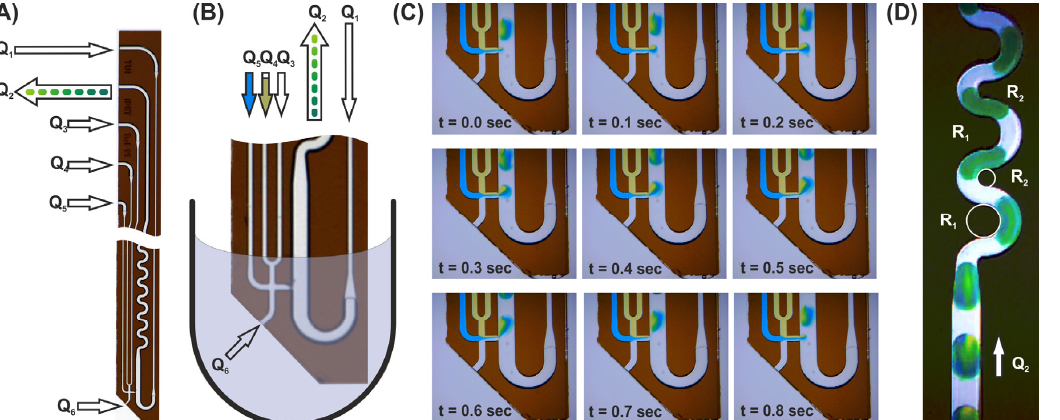
Figure 3. ( A ) Image of the glass made transfer tool. The arrows represent the different flow rates (Q i ) for operation. The device is 16 mm long, 6 mm wide, and possess a thickness of about 1.4 mm. ( B ) Immersed tool tip for sample aspiration (schematic). ( C ) Image series of the droplet generation process. The mass balance of the actively controlled flow rates Q 1–5 determine the sample aspiration flow rate V 6 . Sample volume will be aspirated as long as the sum of the derived flow rates Q 1 + Q 3 + Q 4 + Q 5 are less than the aspiration flow rates Q 2 . The sample flow rate can then be calculated by Q 6 = Q 2 − (Q 1 + Q 3 + Q 4 + Q 5 ). V 1 is the flow rate which provides the immiscible separation medium. The ratio between Q 1 /(Q 3 + Q 4 + Q 5 +Q 6 ) determines the droplet distances and is usually set to about 1. ( D ) Image of mixing droplets as they pass through the meandered channel. The meander is designed with two different radii (R 1 = 2 × R 2 ) in the channel curvatures for fast dean mixing. (Further details see text).